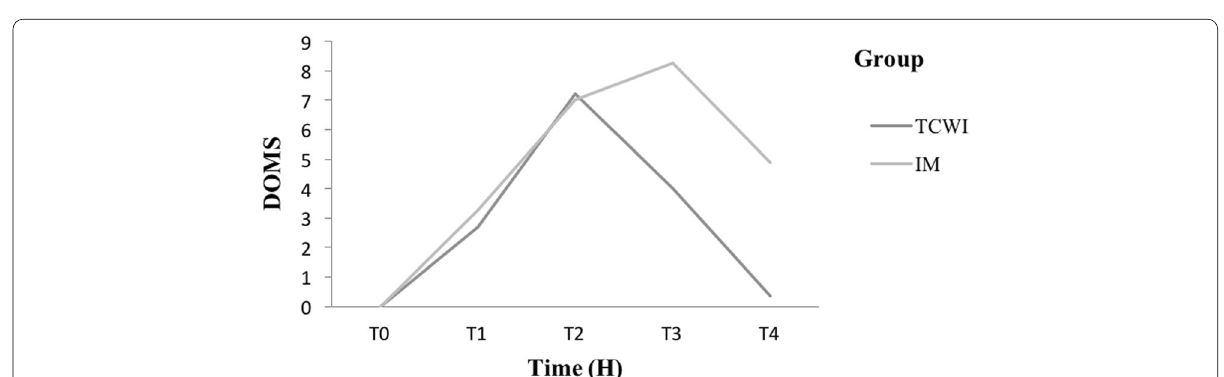
Fig. 4 Variation of delayed onset of muscle soreness values between groups at different